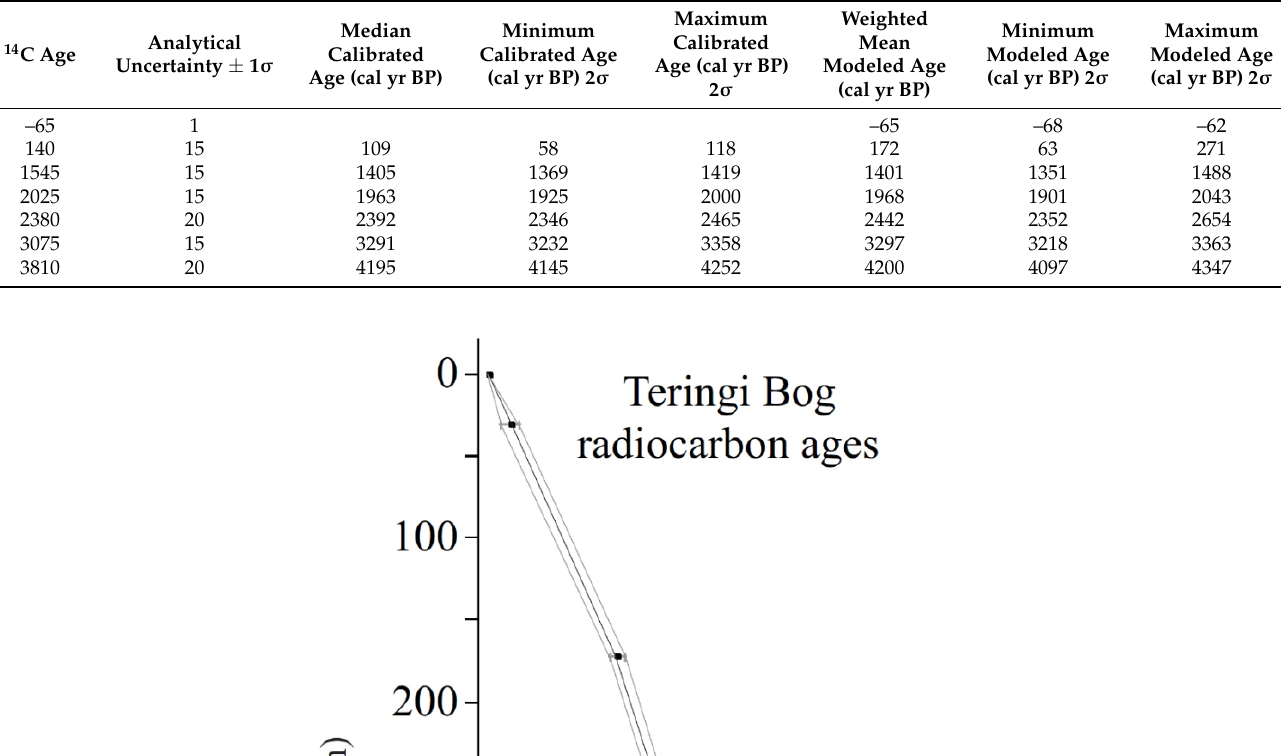
Table 1. Radiometric ages used in study. All samples were measured on Sphagnum stems.